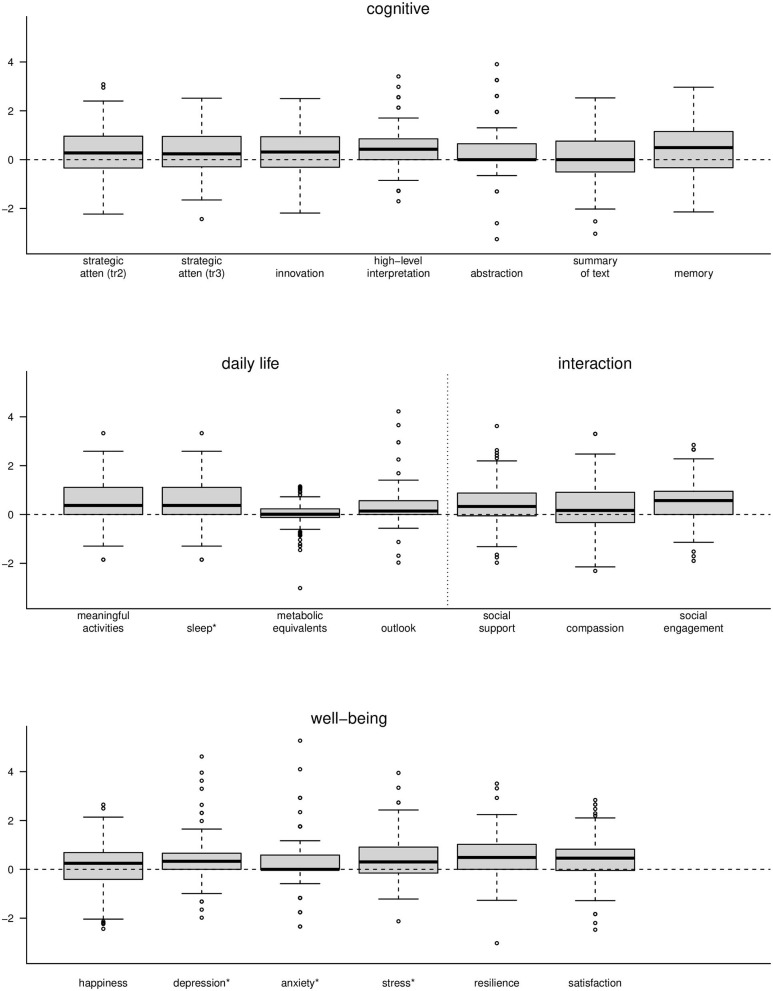
Boxplots of change measures for each of the components of the BrainHealth wheel. Each measure was scaled for presentation on a common axis. *The measures for sleep, depression, anxiety, and stress are shown with opposite sign.